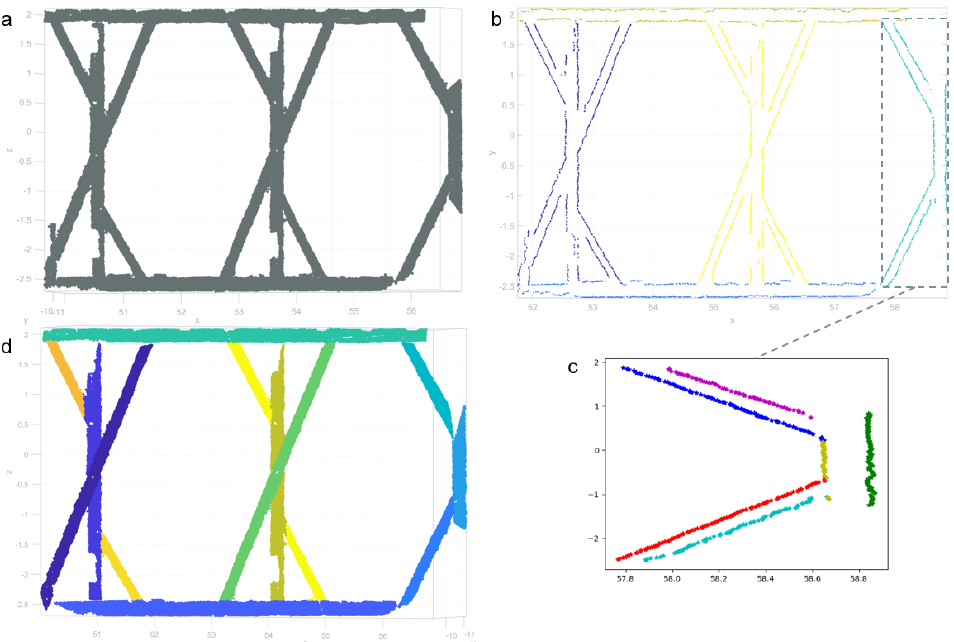
Figure 10. Type-2 segment ( a ), 2D region growing segmentation on alpha-shape ( b ), multi-line fitting with RANSAC ( c ) and linear split sub-segments ( d